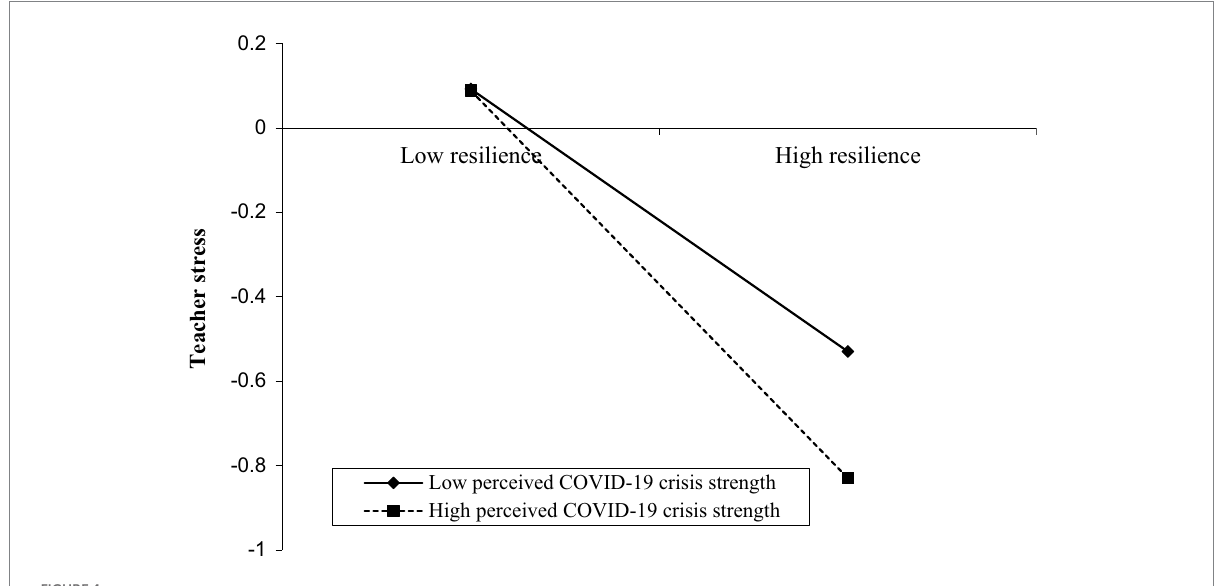
FIGURE 4 Perceived COVID-19 crisis strength moderates the indirect relationship between psychological resilience and teacher